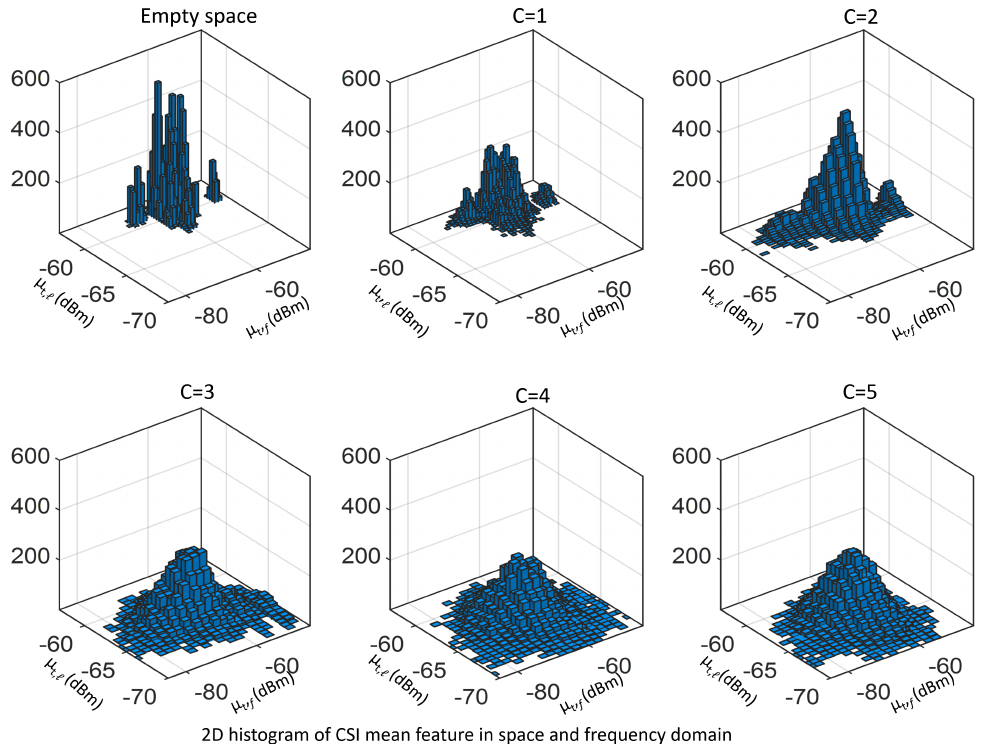
Figure 5. 2D histogram of CSI mean in space (i.e., µ t , f ) and frequency (i.e., µ t , (cid:96) ) domain for the empty space case and the subject number ranging from 1 up to